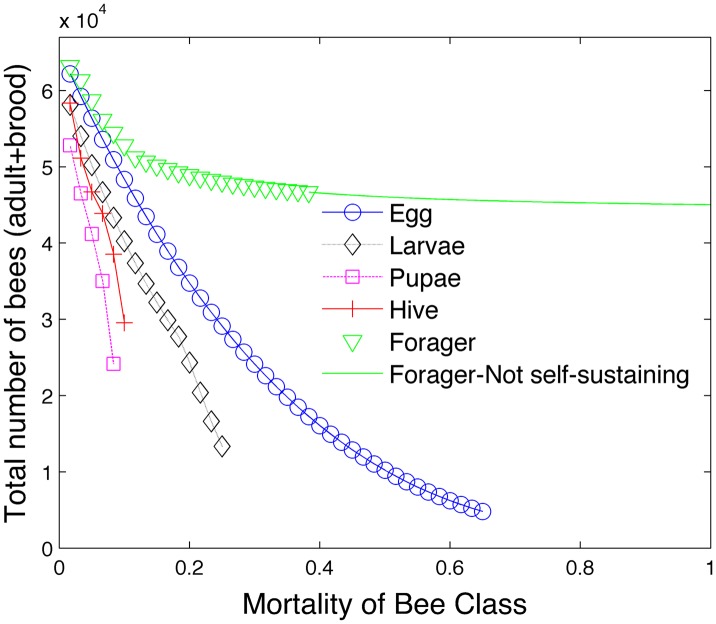
Effect of mortality on bee population.